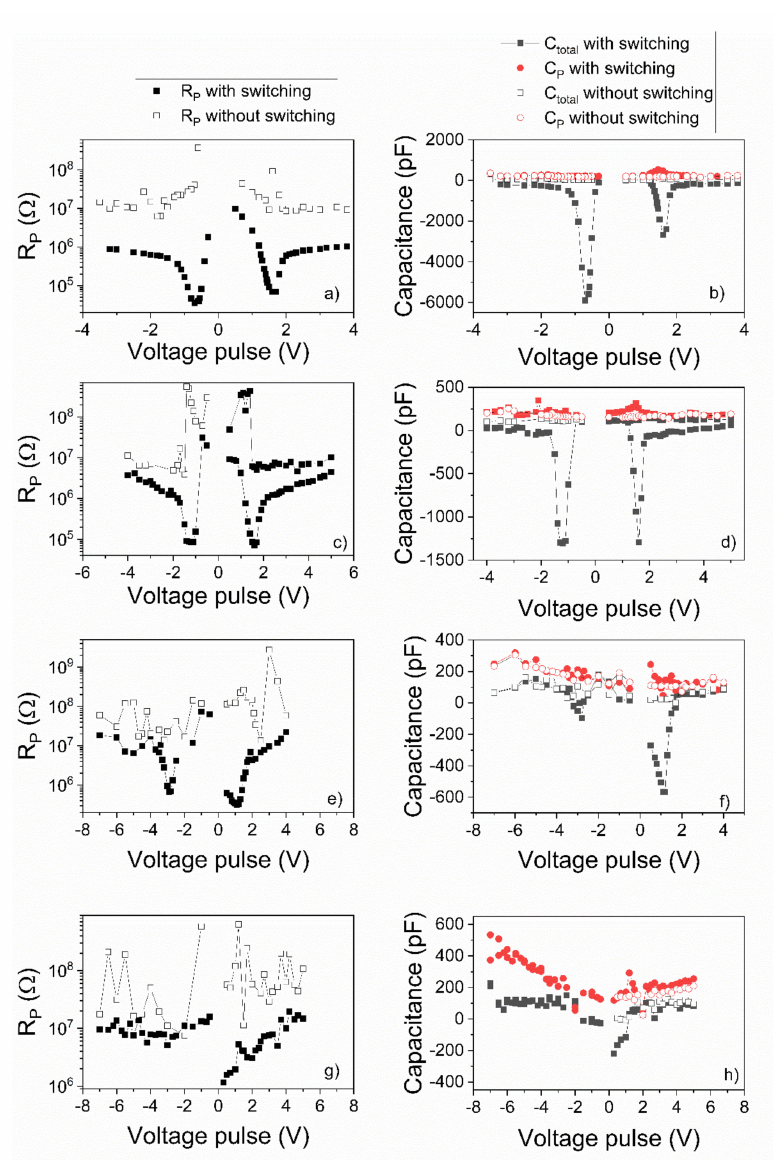
Figure 5. The dependence of the equivalent parallel resistance (R_P), total capacitance (C_total) and parallel capacitance (C_P) on the voltage pulse amplitudes. First ( a , b ) and second ( c , d ) lines are attributed to the epitaxial PZT thin films deposited from the commercial target and from “pure” target, respectively. The 3rd ( e , f ) and 4th ( g , h ) lines are attributed to the polycrystalline PZT film deposited by spin-coating on the SRO/STO single crystal substrate (SRO deposited by PLD) and on the Pt-coated Si substrate,